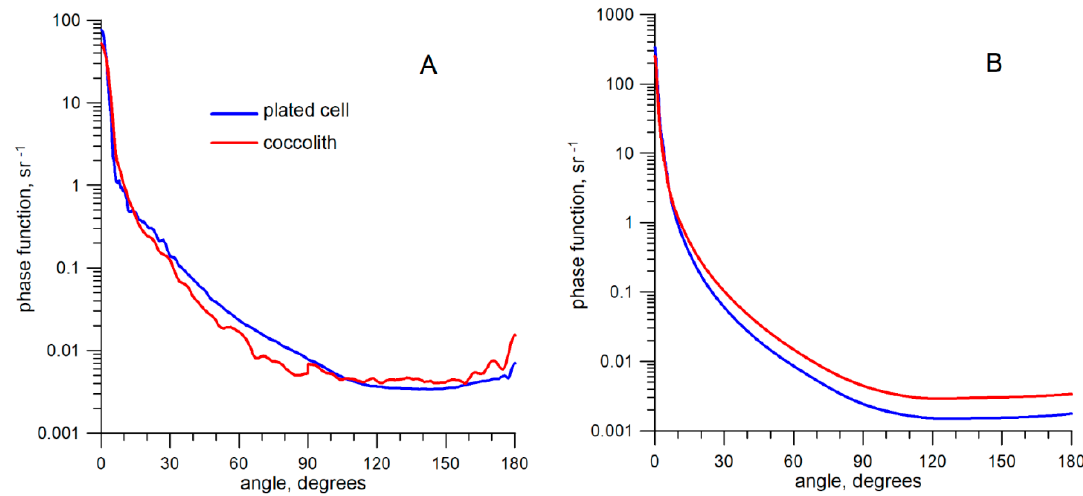
Figure 2. The phase scattering function: ( A ) For the plated cell and coccolith; ( B ) For the non-coccolithophore particles in the Black Sea (red curve) and the Barents Sea (blue). As seen from Figure 2A, the phase scattering functions for the plated cells and coccoliths are